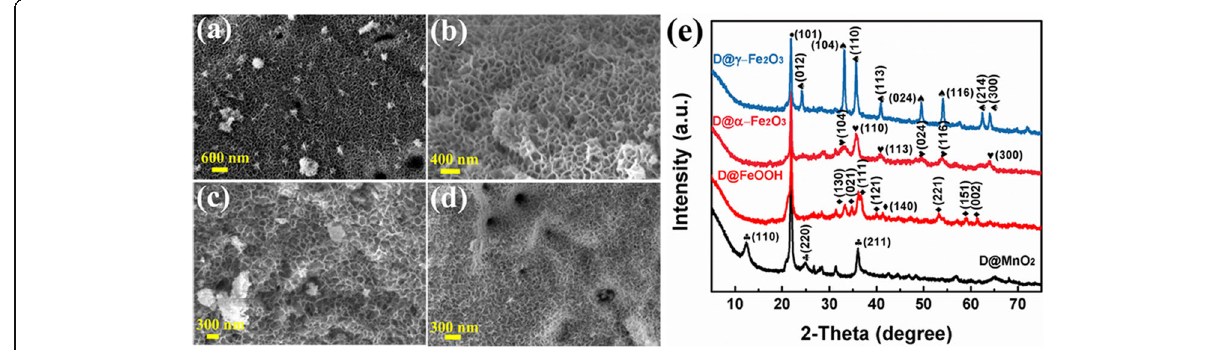
Fig. 2 SEM images of diatomite@MnO 2 nanocomposite ( a ), diatomite@FeOOH nanocomposite ( b ), diatomite@ α -Fe 2 O 3 nanocomposite ( c ), diatomite@ γ -Fe 2 O 3 nanocomposite ( d ); XRD pattern of the four samples ( e